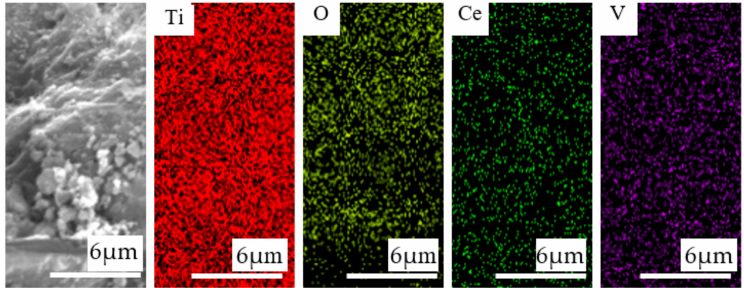
Figure 7. Scanning electron microscopy (SEM) images and mapping images of the Ce-V-Ti / GO(0.7)